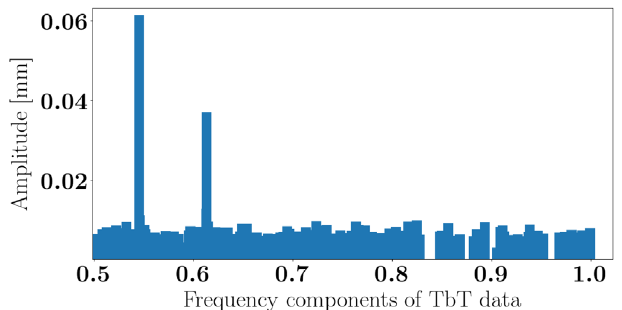
FIG. 16. Orbits calculated as the average of all position measurements from turn by turn data taken during the K modulation measurements. The different colors indicate different modulations in the QC1LE and QC1RE magnets, left and right of the IP, respectively. The orbits are plotted as the deviation from the orbits found before modulating the